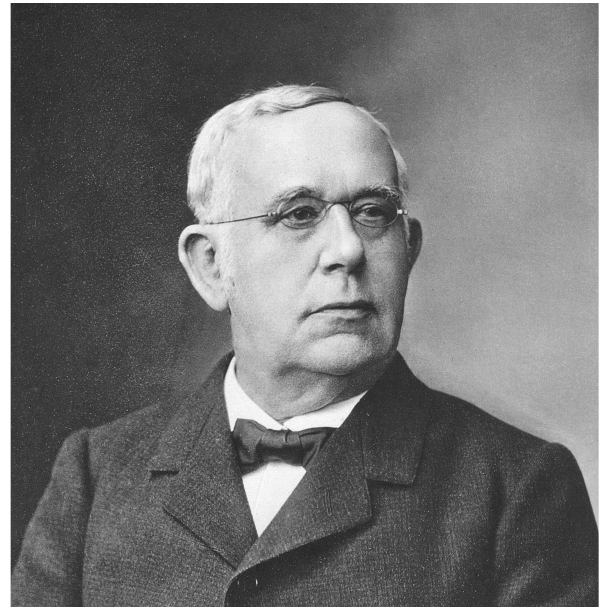
Figure 8. Adam F. W. Paulsen (Litograph, A., Ecksteins Verlag,